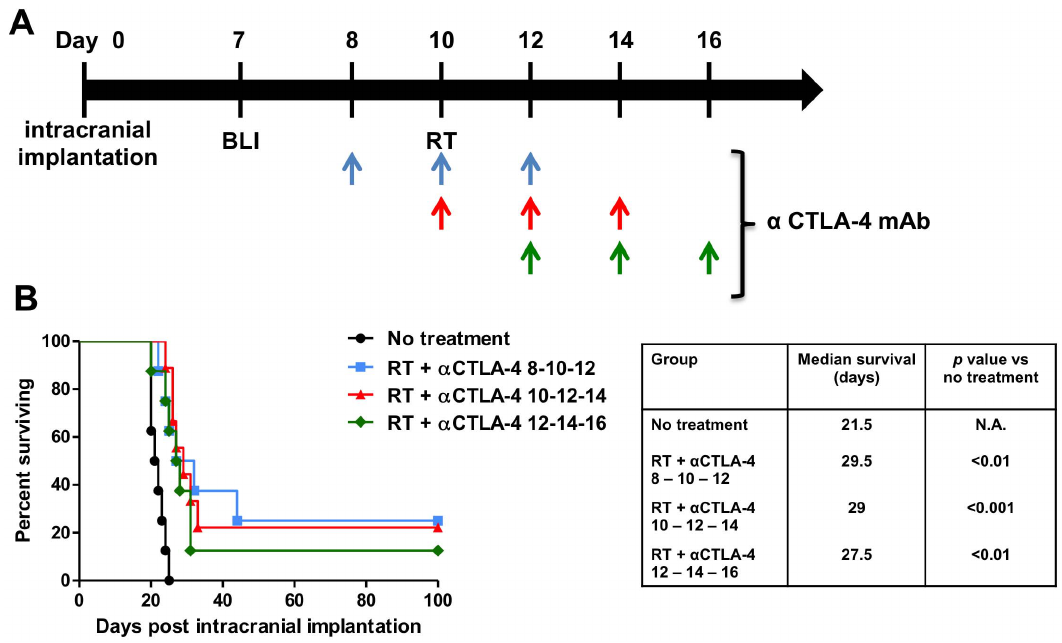
Figure 2. The role of timing in efficacy of anti-CTLA-4 antibody therapy. A) Schematic of the treatment protocol for the CTLA-4 blockade timing experiment. Please note that all treated animals received RT on day 10 and three antibody injections in three different timing schedules (colored arrows). B) Combination therapy with RT and CTLA-4 blockade results in long-term survival compared to controls ( p , 0.01), however, there was no significant difference in treatment efficacy between the three combination therapy groups. P values were calculated with the Log-Rank test.